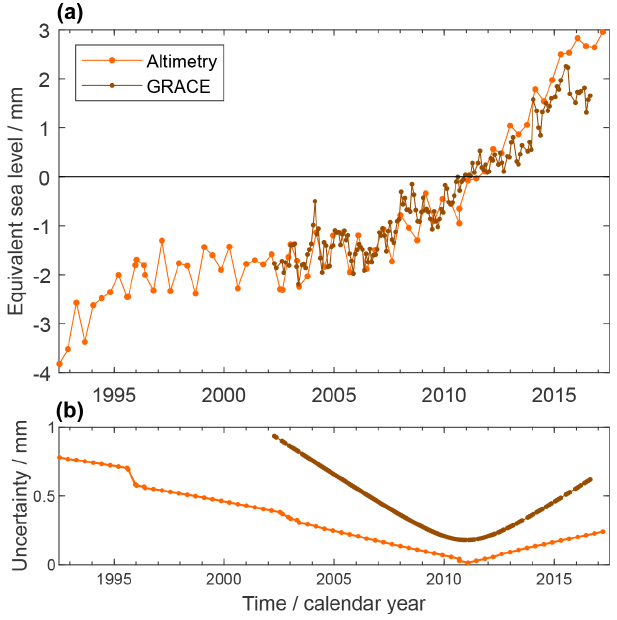
Figure 7. (a) Antarctic Ice Sheet mass change contributions to GMSL from GRACE (dark orange) and altimetry (orange). Ice- mass change is expressed in terms of equivalent GMSL change with respect to the mean of the reference interval of 2006–2015. The tem- poral sampling is quasi-monthly (with a few months missing) for the gravimetric time series and 140-daily (with a few shorter time increments) for the altimetric time series. (b) Uncertainties assessed for the estimates in (a)